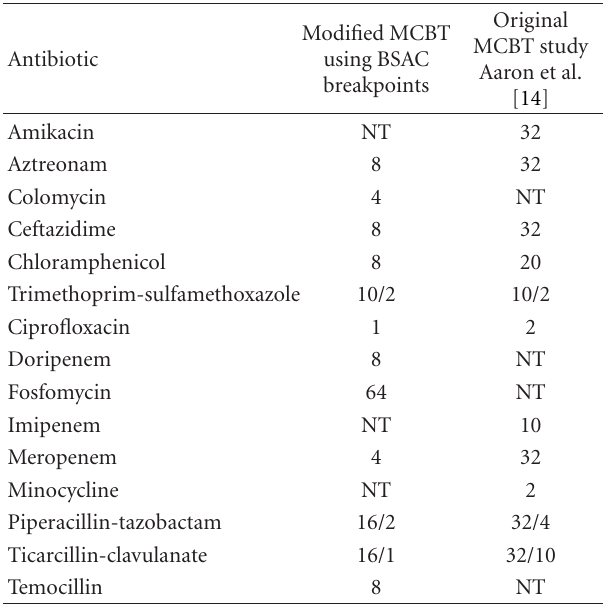
Table 3: Antimicrobial agents and breakpoint concentrations (mg/L) used in the Multiple Combination Bactericidal